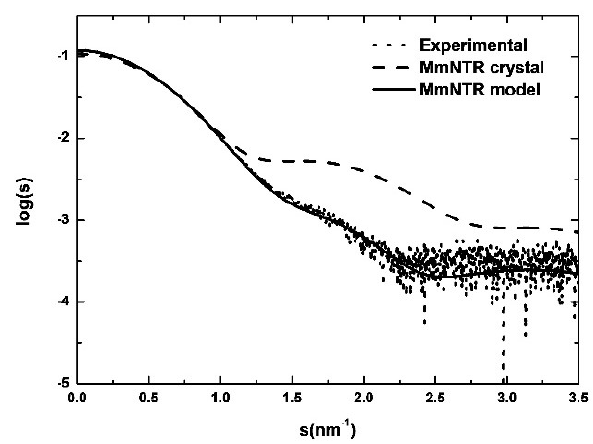
Figure 5. The SAXS study of MmNTR. Experimental SAXS data (dots) overlaid with the theoretical scattering curves that were computed from the crystal structure (dashed line) and the model (continuous line).